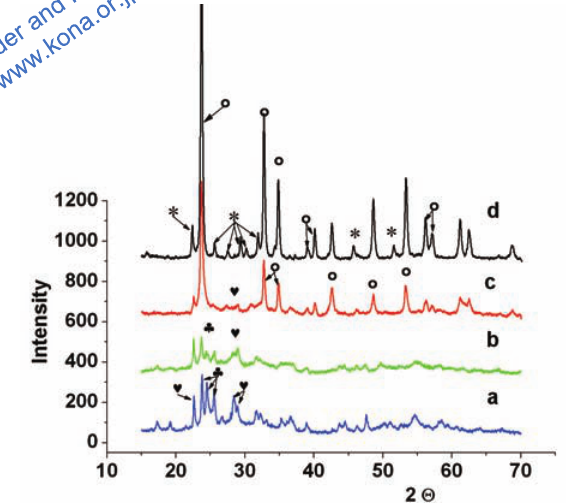
Fig. 5 Diffraction patterns of mechanically activated mixture: a) − 30 minutes, 0.1 CuO and the products of its thermal treatment